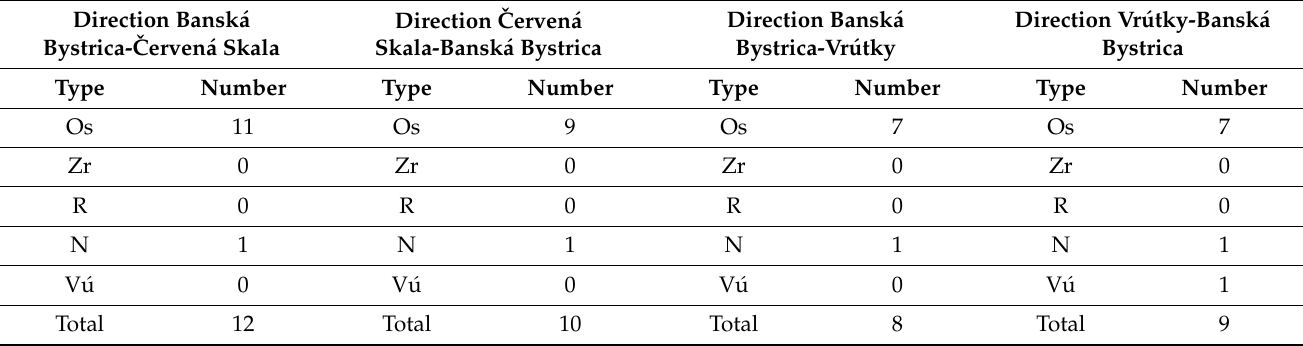
Table 3. Number and type of trains during the measurement BB2.